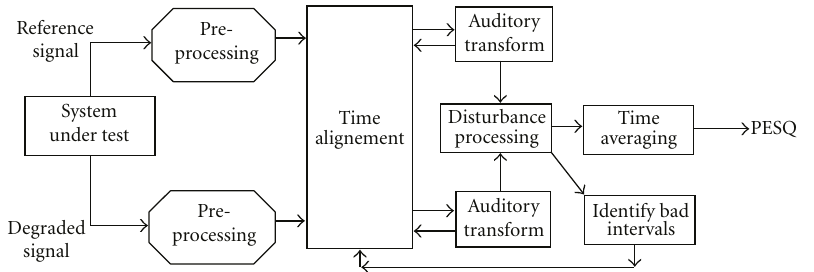
Figure 6: Block diagram of the PESQ measure computation